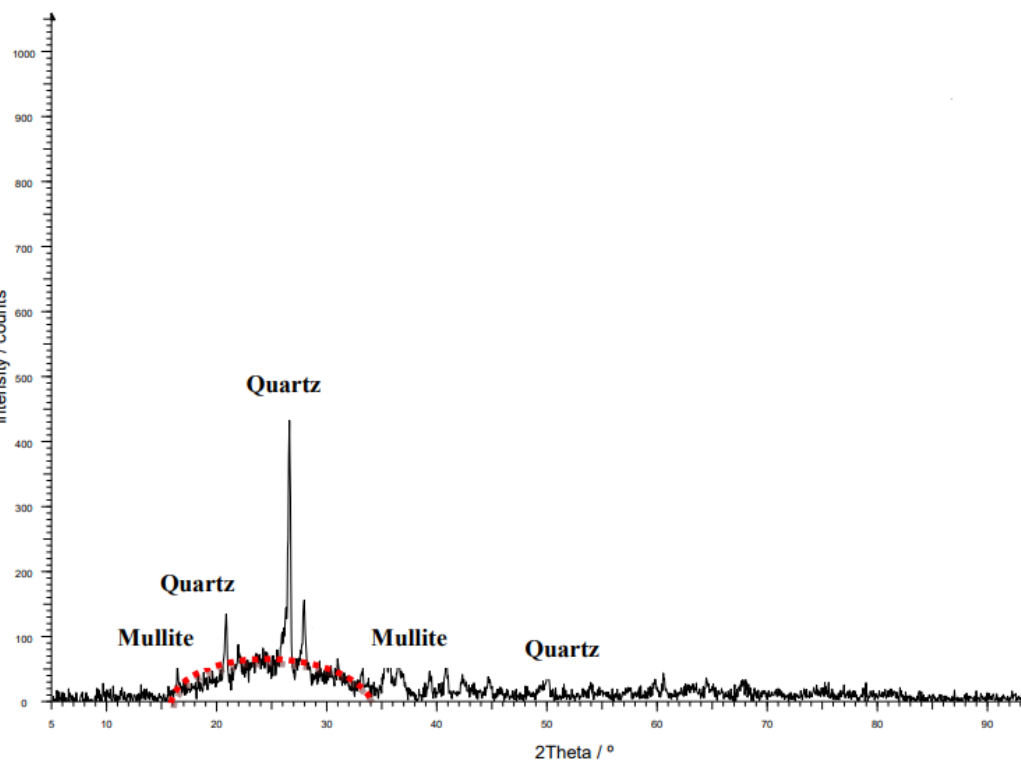
Figure 1. XRD pattern of the lightweight fly ash aggregate.